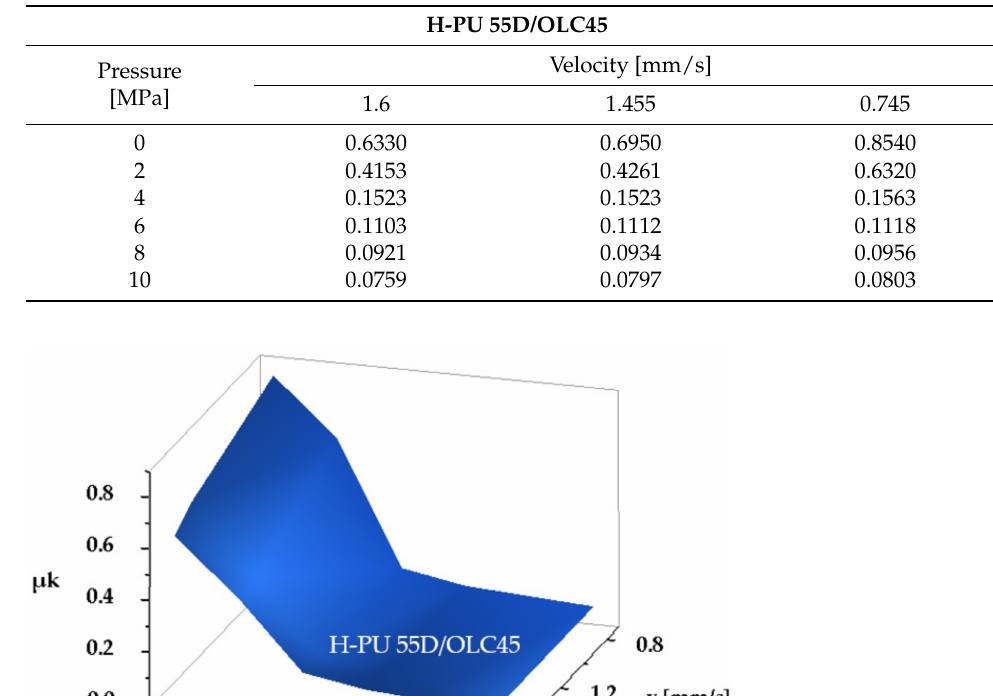
Table 4. Dependency of µ kmin on contact pressure and velocity (H-PU 55D/OLC45).